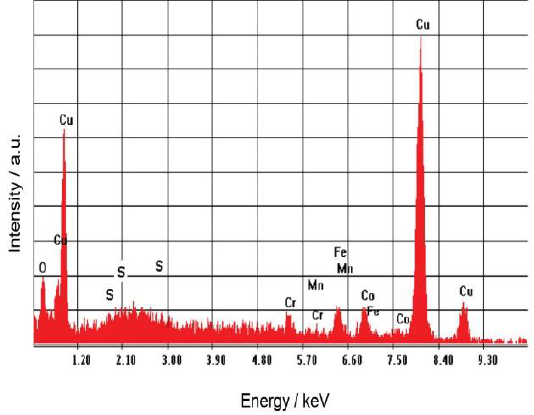
Figure 11. EDS spectra for the equimolar CoCrFeMnNi thin film, sample 1, after corrosion. SEM images of the CoCrFeMnNi thin-film sample 2 (Figure 12) show an outer layer of submicron globular particles with significant gaps between particles (Figure 12b). After cor- rosion, the SEM images (Figure 13) show that the shapes in the outer layer have sharpened significantly, leaving a uniform outer layer of thin walls, replacing the globular shapes of the original film.